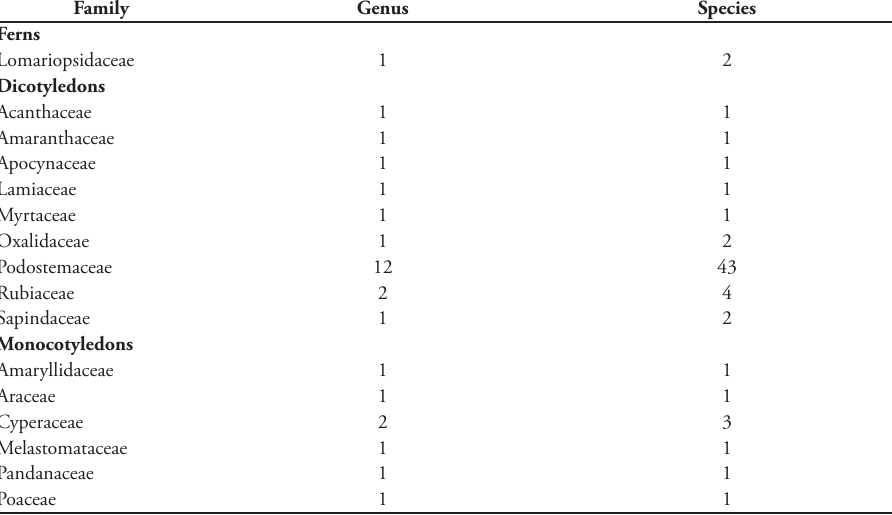
Table 1. Number of rheophyte species and genera per family in